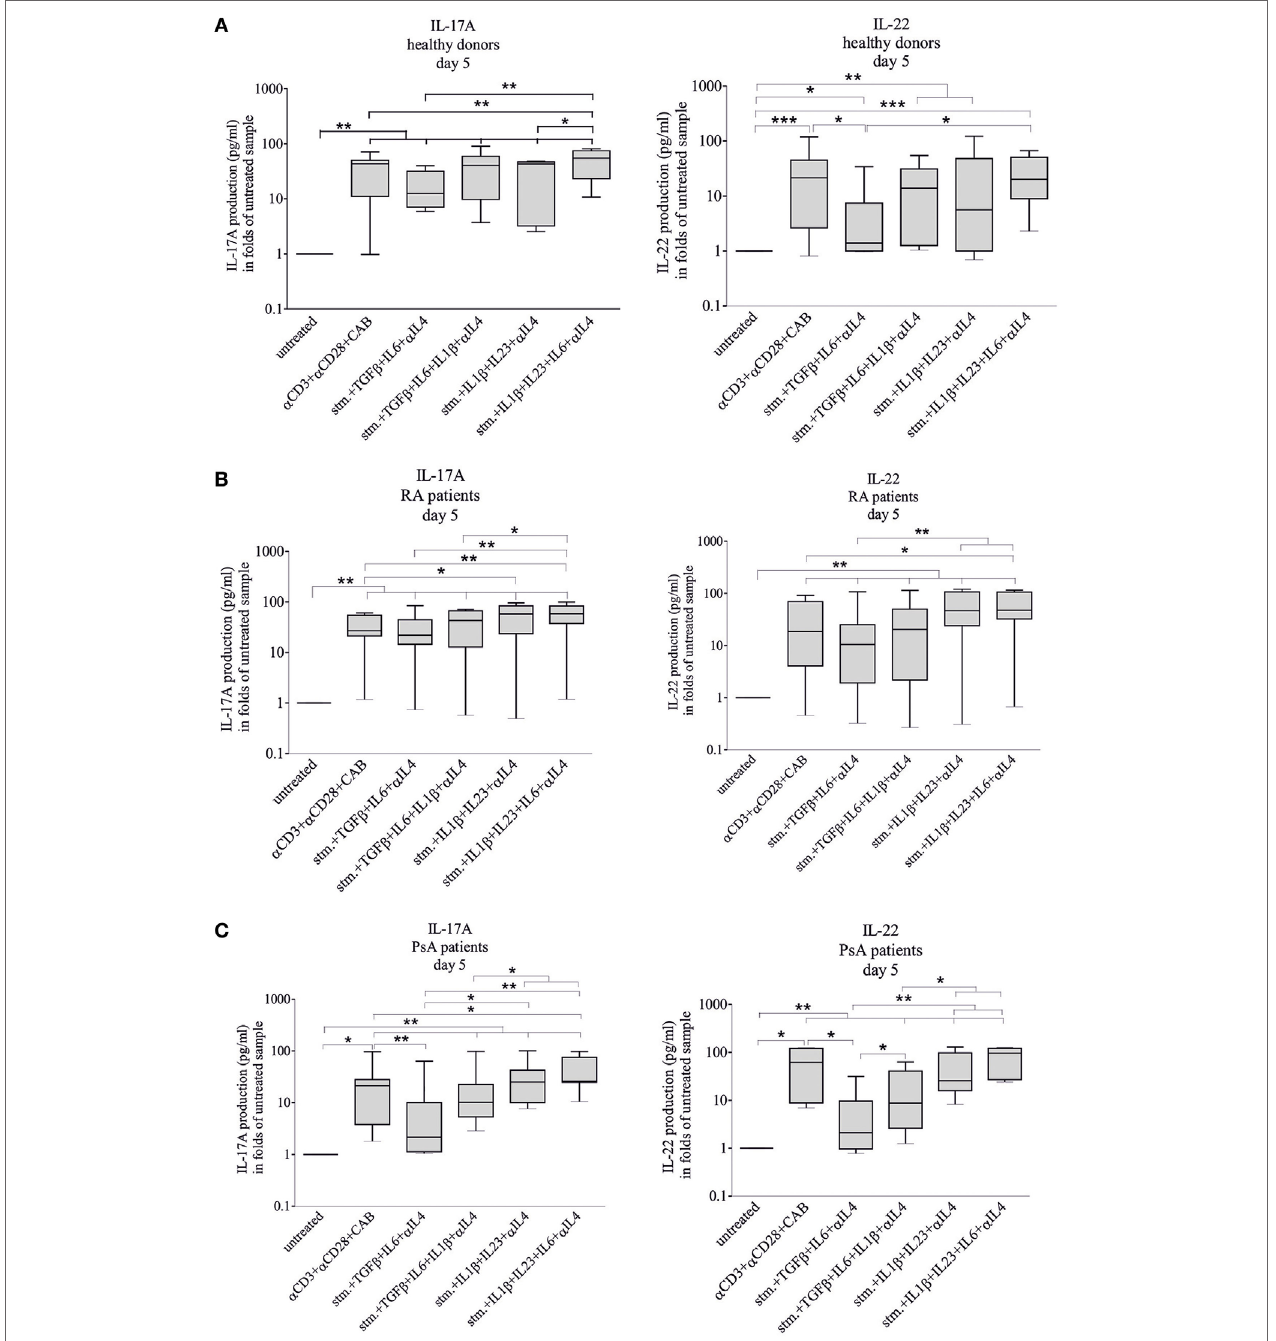
FigUre 5 | Interleukin-17A (IL-17A) and IL-22 cytokine secretion during differentiation. IL-17A and IL-22 cytokine secretions were measured during T-helper 17 differentiation of naive healthy- [ (a) n = 12], rheumatoid arthritis (RA)- [ (B) n = 9], psoriatic arthritis (PsA) patient-derived [ (c) n = 7] CD4 + T cells. Naive CD4 + cells were stimulated and treated with cytokines as described earlier. The IL-17A and IL-22 levels were measured by enzyme linked immunosorbent assay method. Untreated cells on fifth day served as controls; the data are shown in a logarithmic scale. Median, minimum, and maximum values were indicated (Friedman test and pairwise Wilcoxon signed rank test, * p < 0.05, ** p < 0.01, and *** p <